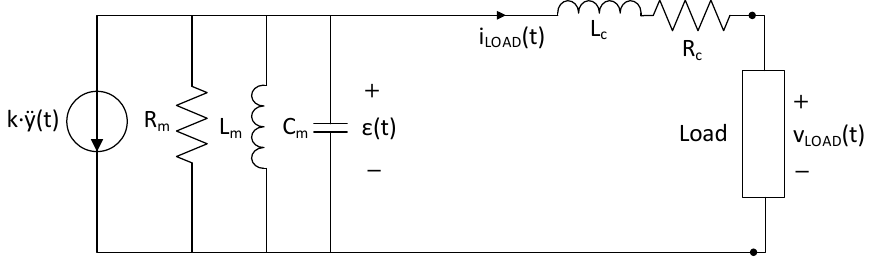
Figure 2. Equivalent circuit of a standard single coil resonant electromagnetic vibration energy harvester.